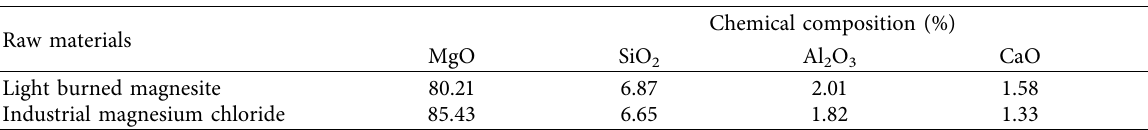
Table 2: Physical properties and chemical composition of raw materials.